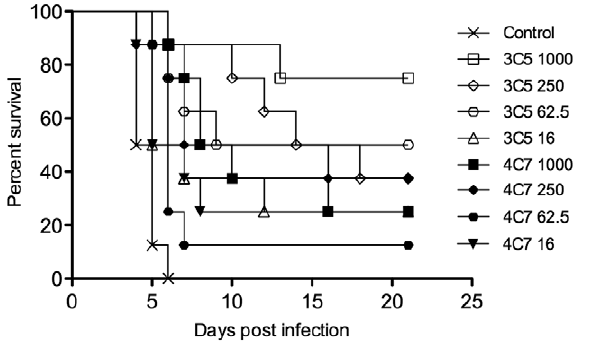
Figure 3. Protection in passively immunized mice following i.n. challenge with B. pseudomallei strain K96243. mAbs were administered by the i.p. route at the doses ( m g) listed. Intranasal challenge was performed 18 h later with 2 LD 50 of B. pseudomallei . Mice were monitored for 21 days. Control mice were treated with 1 mg of an irrelevant IgG3 mAb. p values of survival vs. controls are listed in Table 1.